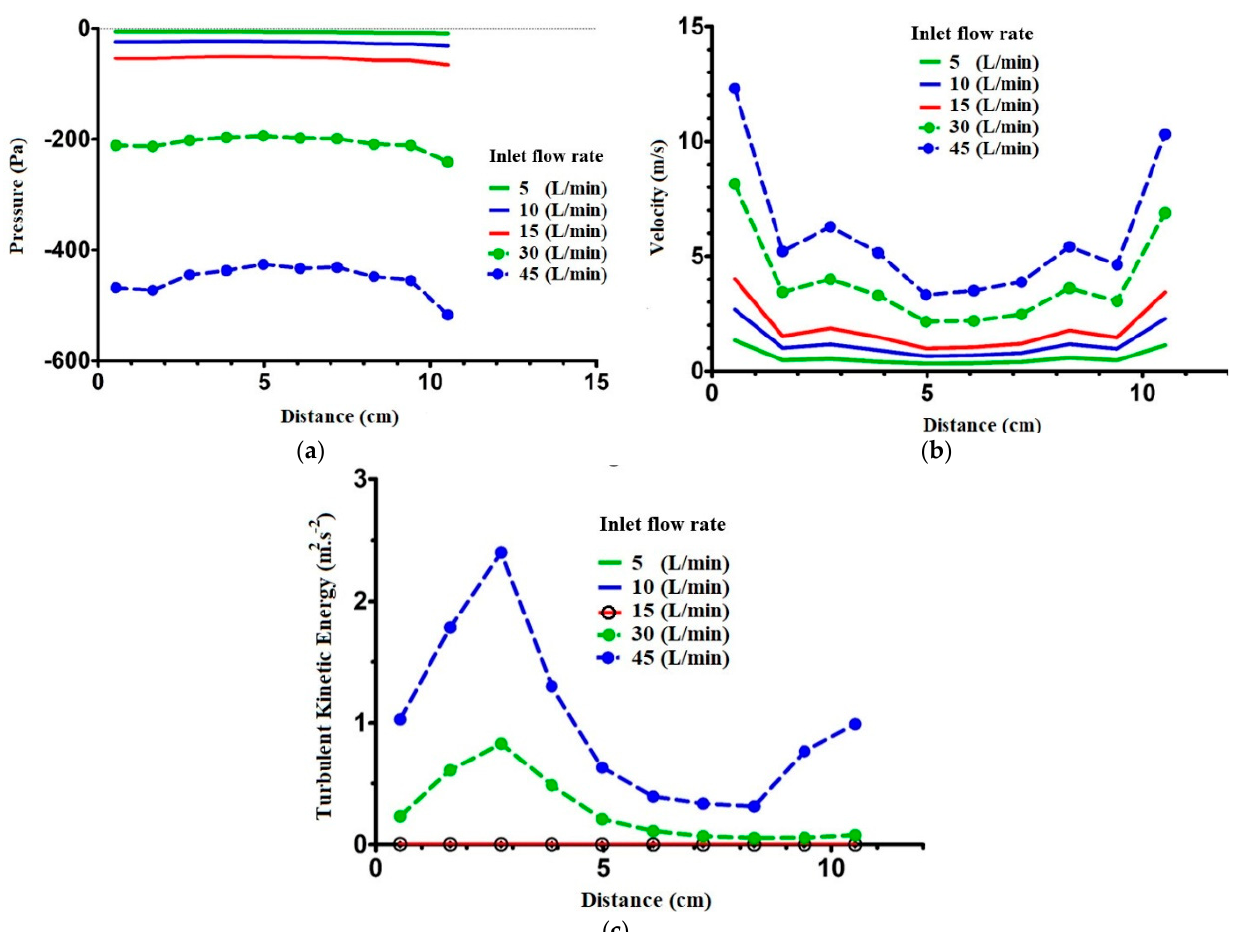
Figure 9. Pressure distribution in SST model at the different inhalation flow rates. ( a ) Effect of distance from vestibule on the pressure; ( b ) effect of distance on velocity magnitude; ( c ) effect of distance on turbulent kinetic energy in the SST model.